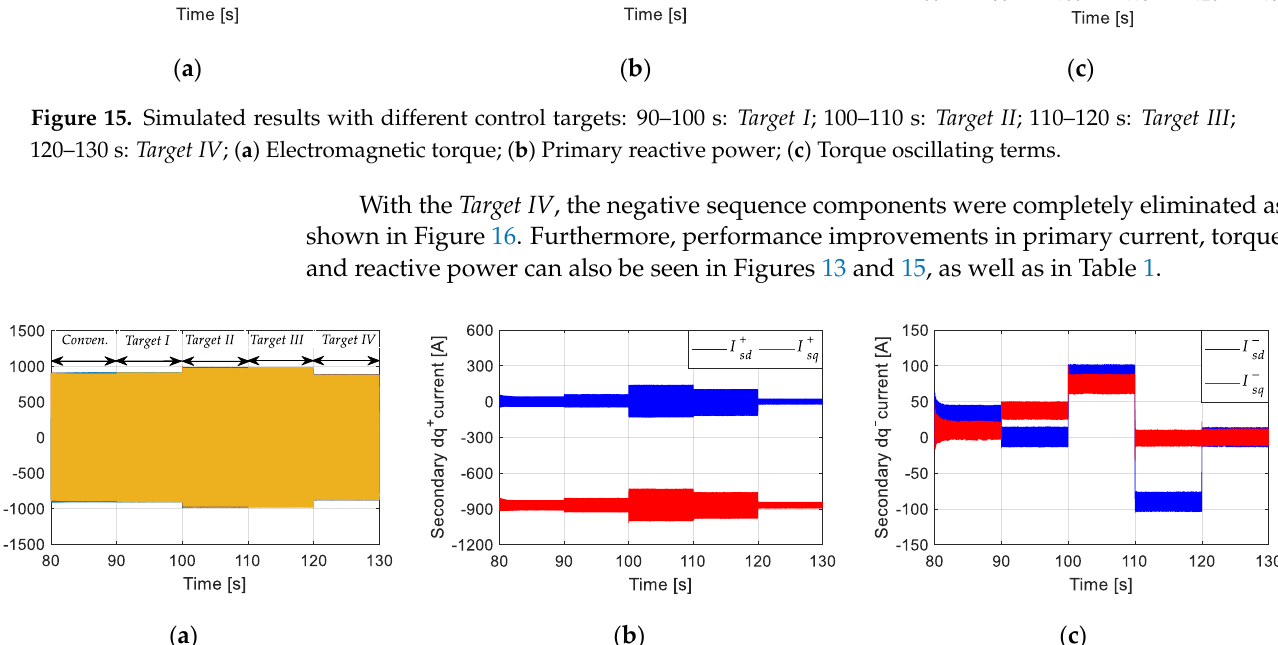
Figure 16. Simulated results with different control targets: 90 – 100 s: Target I ; 100 – 110 s: Target II ; 110 – 120 s: Target III ; 120 – 130 s: Target IV ; ( a ) Secondary current; ( b ) positive components; ( c ) negative components.